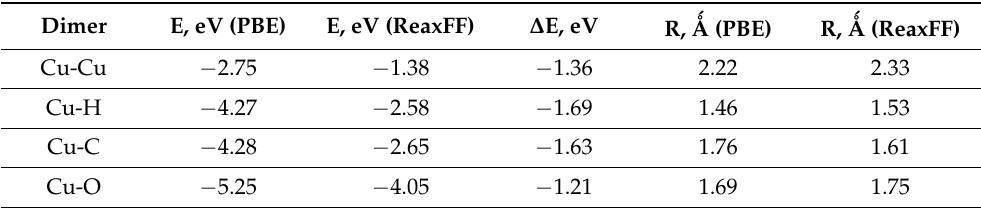
Table 1. Dimer binding energy calculated by DFT and ReaxFF potentials, the energy difference between DFT and ReaxFF, bond length in